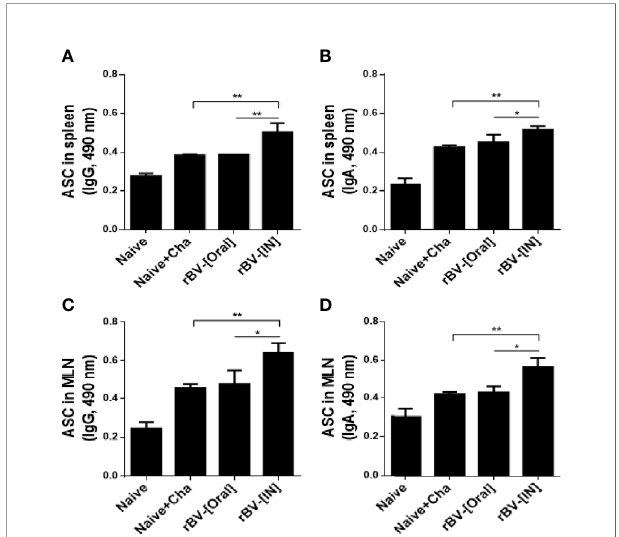
FIGURE 4 | ROP4-rBVs immunization enhances antibody-secreting cell responses. The levels of IgG and IgA antibody-secreting cells were evaluated in spleen and MLN cells. A higher level of T. gondii -speci fi c IgG was found in the group of mice immunized with the IN pathway compared to the Naive+Cha group (A, C) . The group of mice immunized by the oral route is at a similar level to the Naive+Cha group. The group of mice immunized with the IN route responded signi fi cantly to T. gondii -speci fi c IgA (B, D) . Data are presented as mean ± SD and asterisks indicate statistical differences between groups (* P < 0.05, ** P <